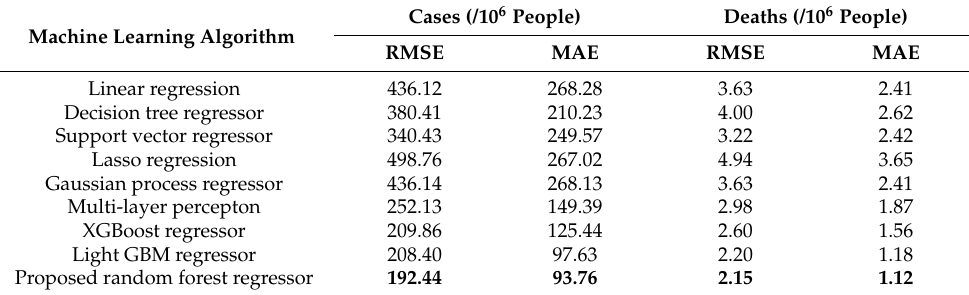
Table 2. The overall performance of machine learning